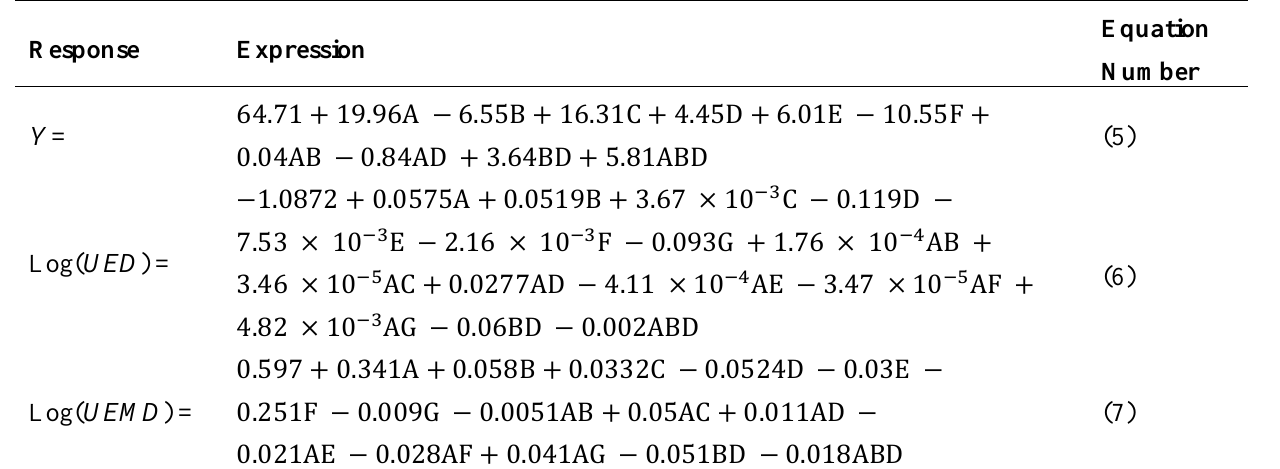
Table 5. Model equations (coded values)*.